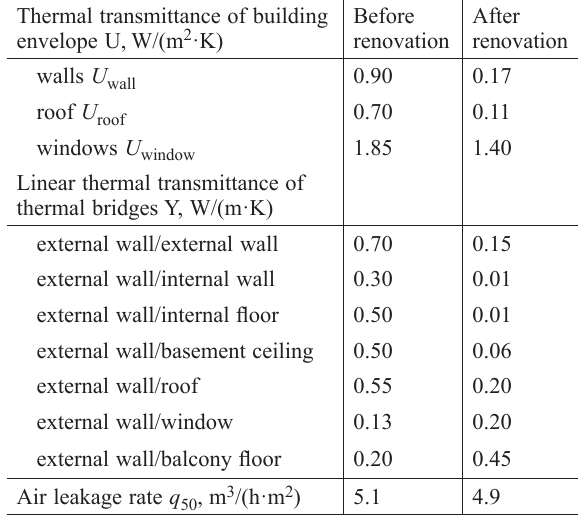
Table 4. Thermal properties of the building envelope